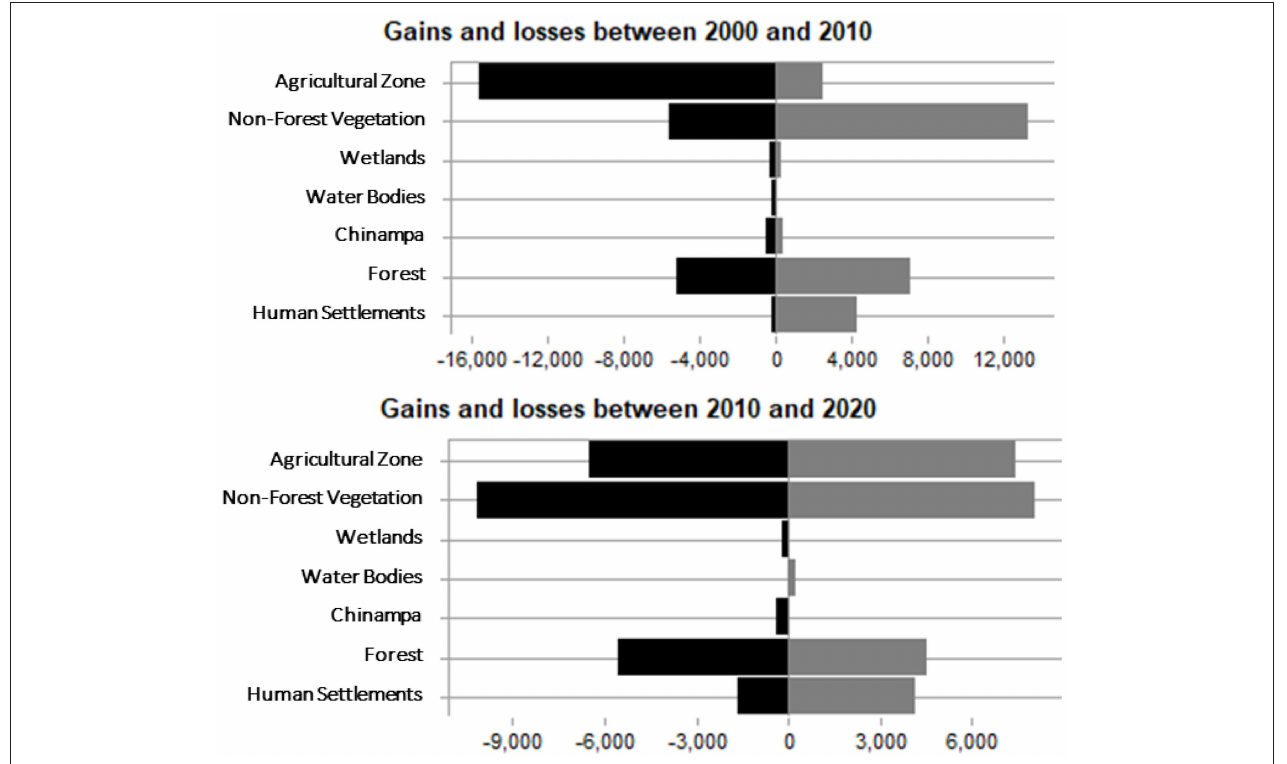
FIGURE 5 | The conservation zone: gains and losses by land use categories, 2000–2020. Elaborated from land use and vegetation layers of Serie II from INEGI (National Institute of Statistics and Geography, 2001); GDF (2012) Atlas Geograf ico de/ Sue/a de Conservaci Ò n de/Distrito Federal; and Esri Land Cover,